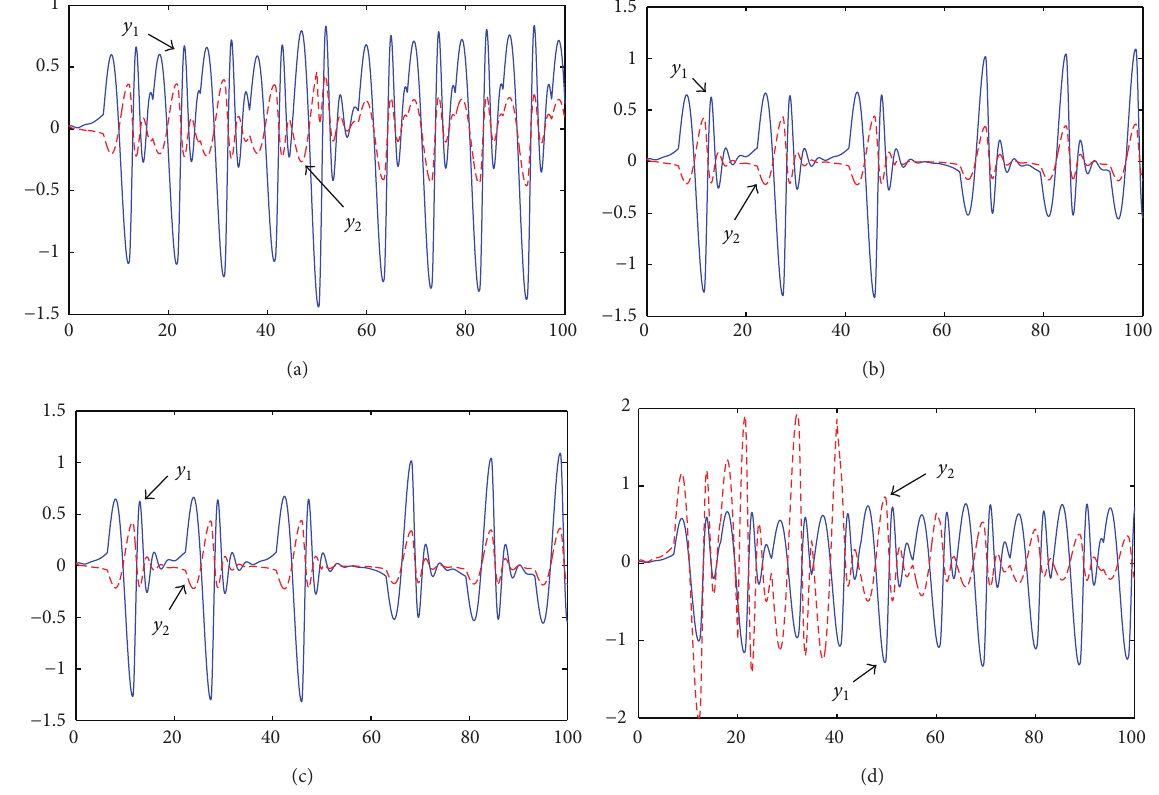
Figure 5: The 𝑦 response when for Case D when (a) {𝛼,𝛽,𝛾,𝑎 1 , 𝑏 1 , 𝑐 1 , 𝑎 2 ,𝑏 2 ,𝑐 2 } = {0.96, 0.96, 0.96, 4, 1, 0.65, 4, 1,0.65} , (b) {𝛼,𝛽,𝛾,𝑎 1 , , 𝑐 ,𝑎 , 𝑏 , 𝑐 } = {0.9, 0.95, 1, 4, 1, 0.65, 4, 1,0.65} , (c) {𝛼,𝛽,𝛾,𝑎 𝑏 1 1 2 2 2 ,𝑎 , 𝑏 , 𝑐 } = {0.95, 0.95, 0.95, 4, 1,0.65, 4,1, 0.65} 𝑐 1 2 2 2